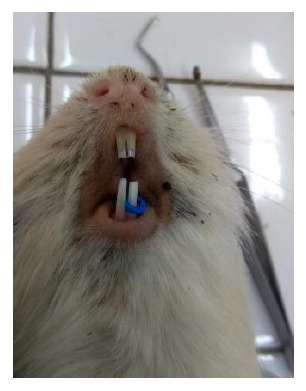
Separator installation on a guinea pig to facilitate the installation of the bracket.